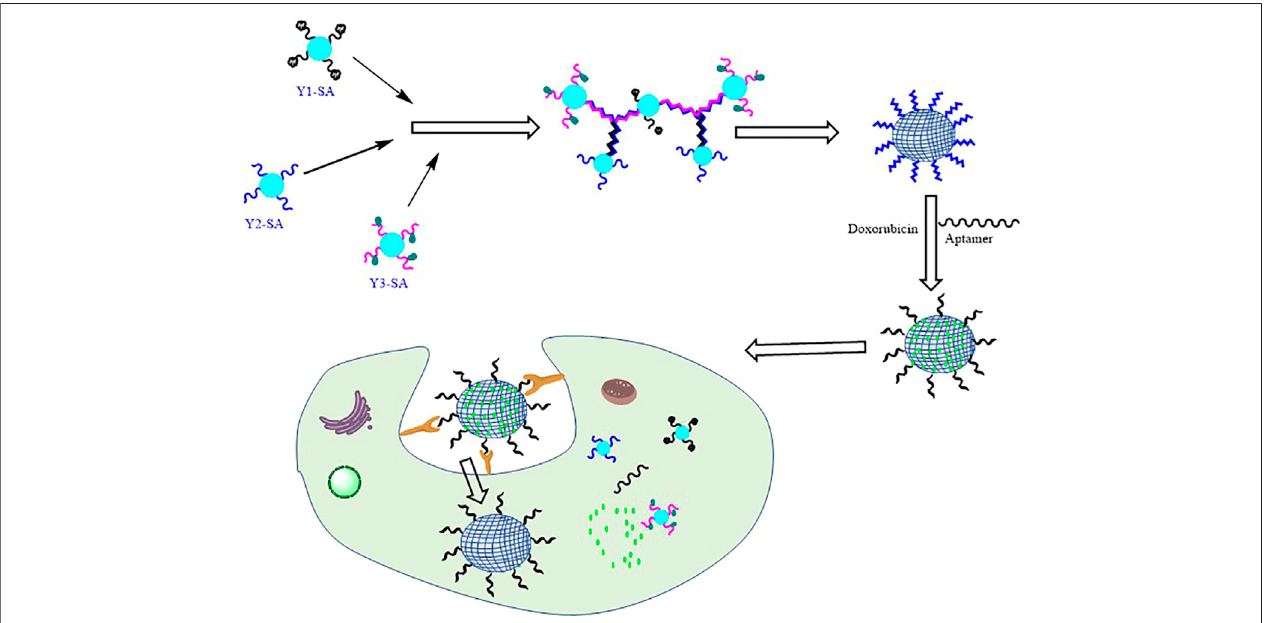
FIGURE 3 | Streptavidin-DNA nanohydrogel for anticancer drug delivery ( fi gure adapted with permission from Li et al., 2019, Copyright 2019, American Chemical Society).